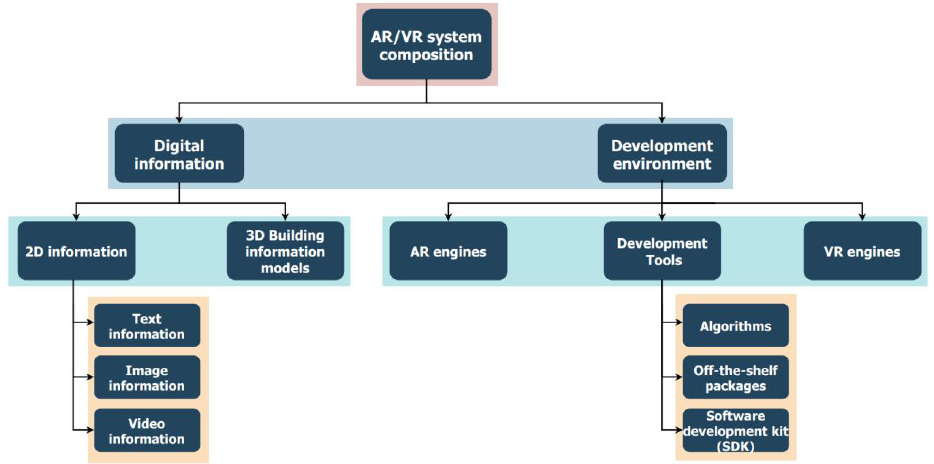
Figure 15. AR/VR system